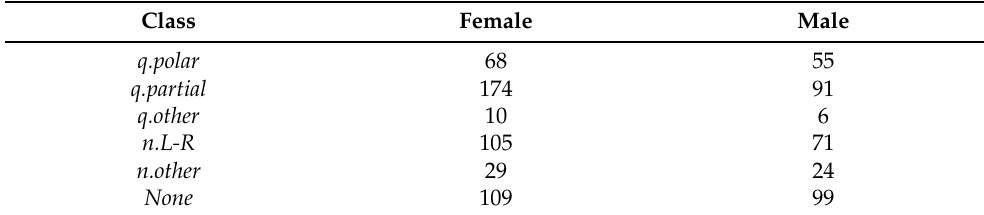
Table 3. Gender distribution in LSE_GFE dataset (#samples).